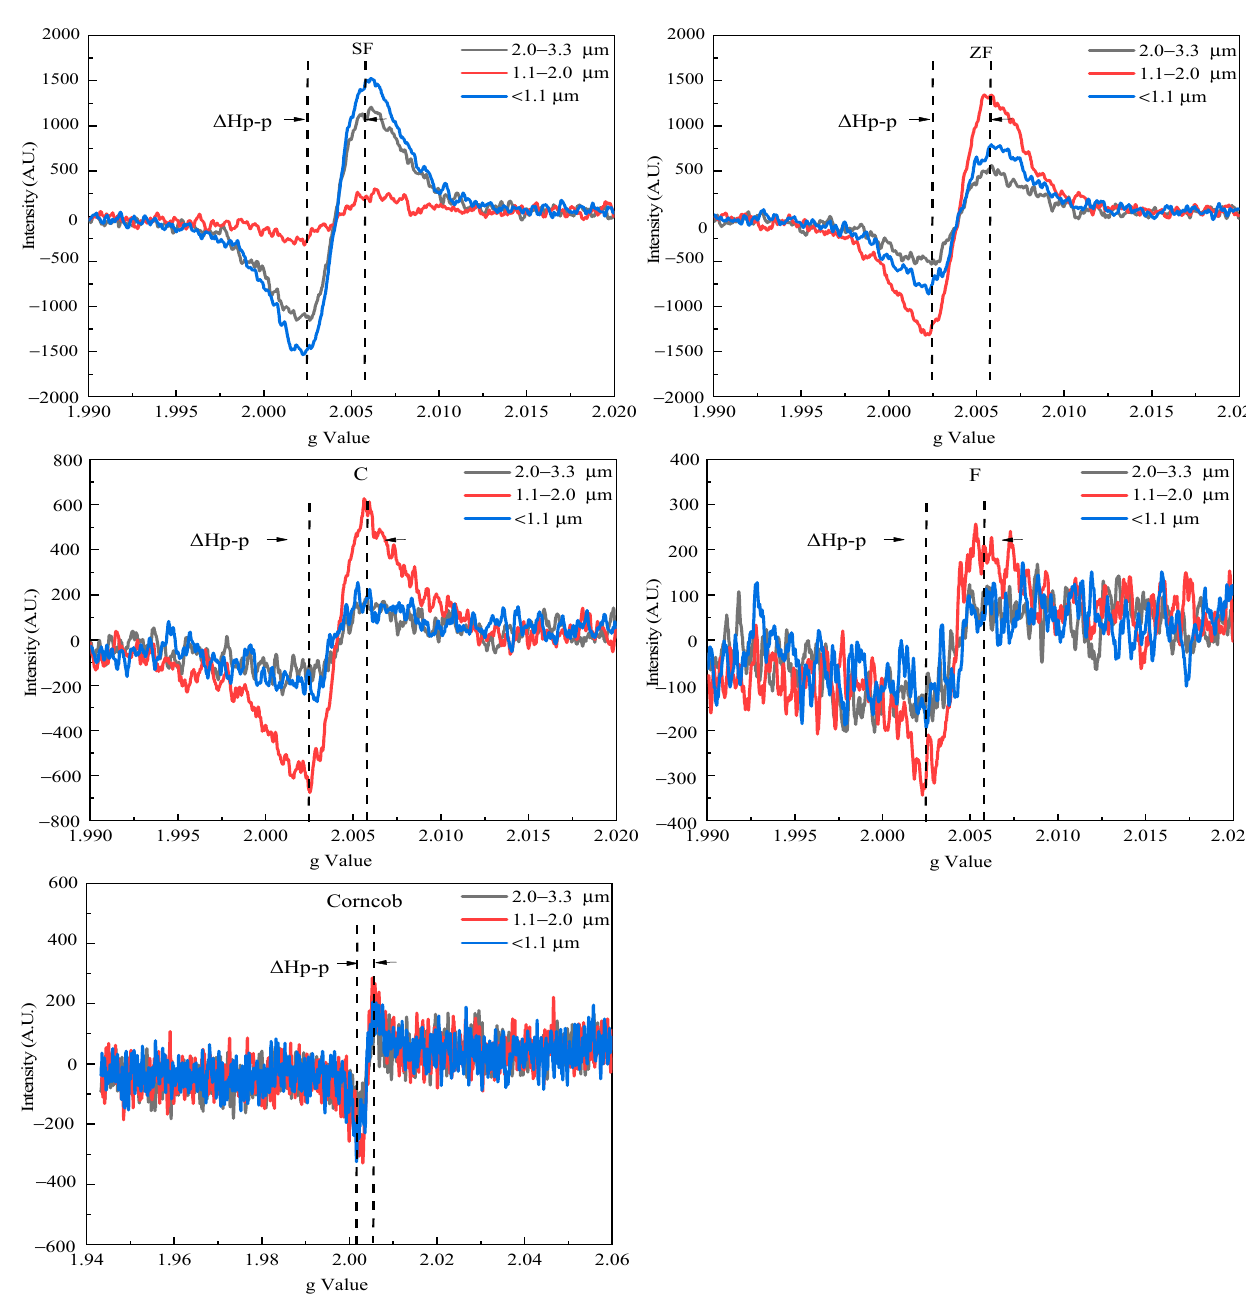
Figure 4. The mean g factor and ∆ Hp-p of the